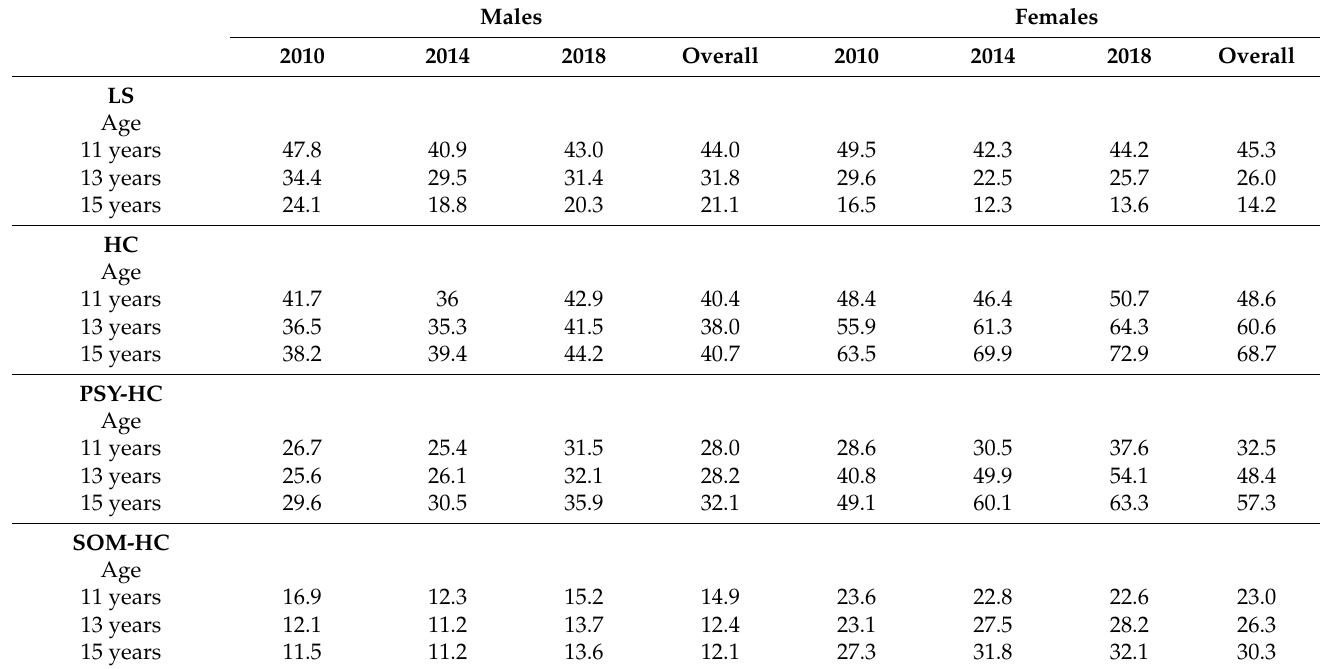
Table A2. Prevalence (%) of outcome variables across surveys stratified by gender and age groups. Males Females